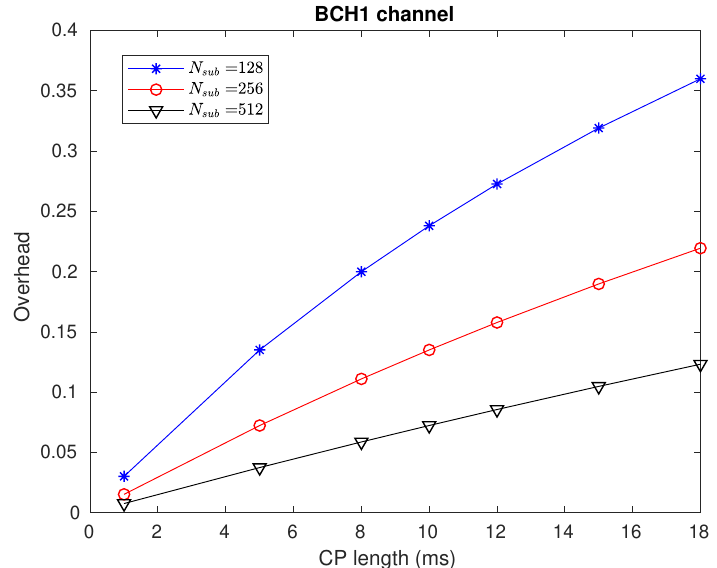
Figure 12. Corresponding overhead for each parameters pair for BCH1 channel.